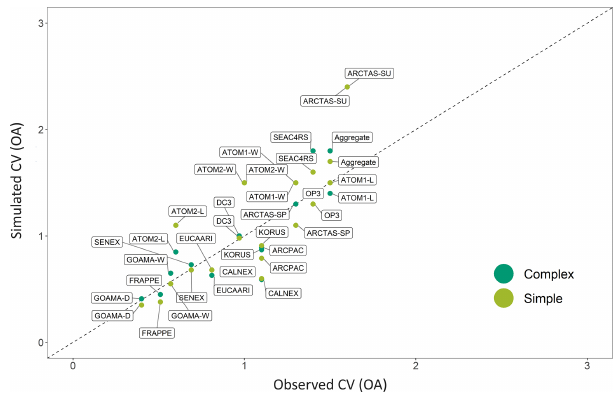
Figure 12. A comparison of the simulated (GEOS-Chem) coeffi- cient of variation (CV, the ratio of the standard deviation to the mean) for the complex (dark green) and simple (light green) OA schemes against the observed CV for each airborne campaign. The one-to-one line is shown as a dashed black